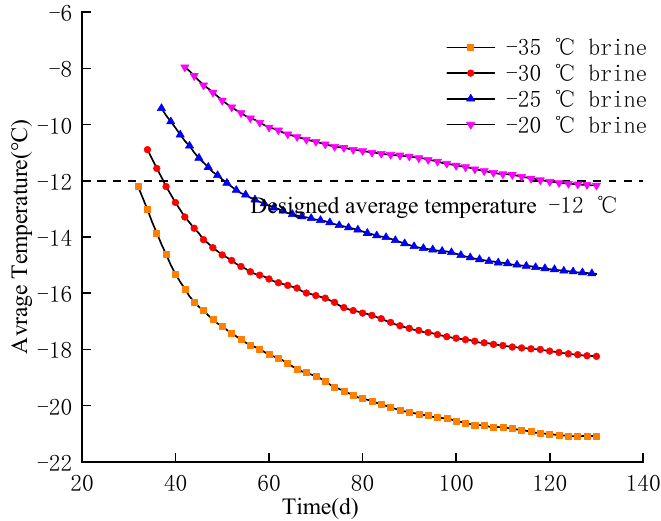
Figure 8. Variation in the average temperature of effective frozen wall with time.